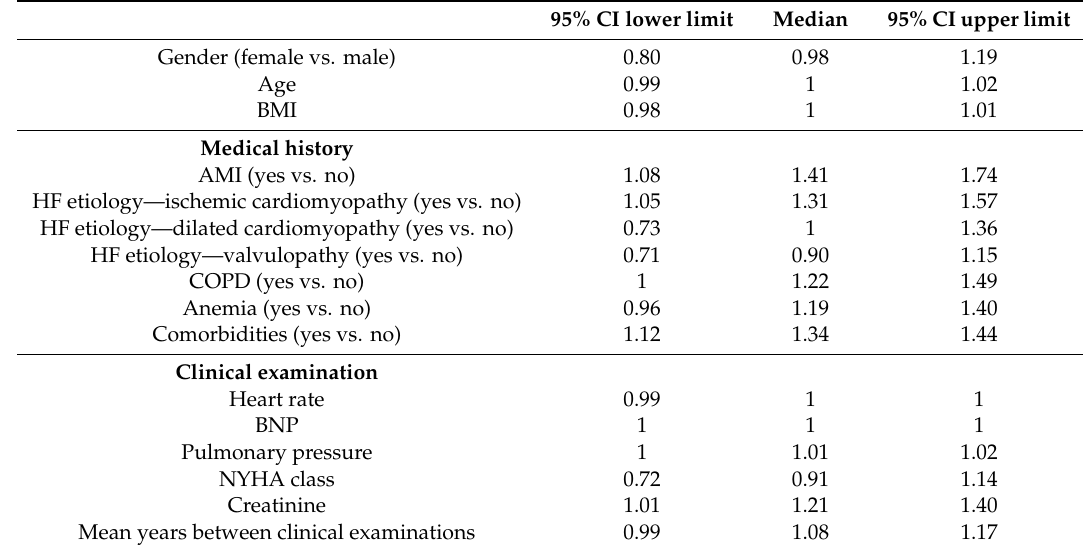
Table 7. Coe ffi cients’ distributions (median and 95% CI) for 10,000 bootstrap repetitions of the model found to have the best performance, i.e., GLMN (alpha = 0.005, lambda = 1 /